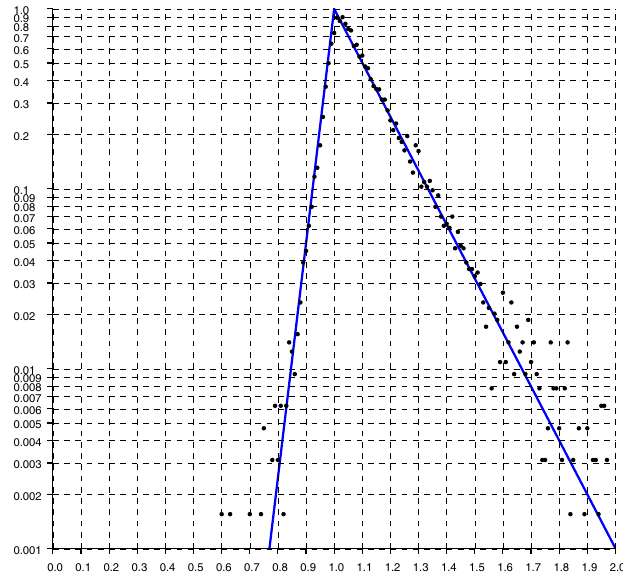
Figure 5. Histogram of the ratio of reported distances to actual distance on a logarithmic scale. The solid line is the “double exponential” parametric